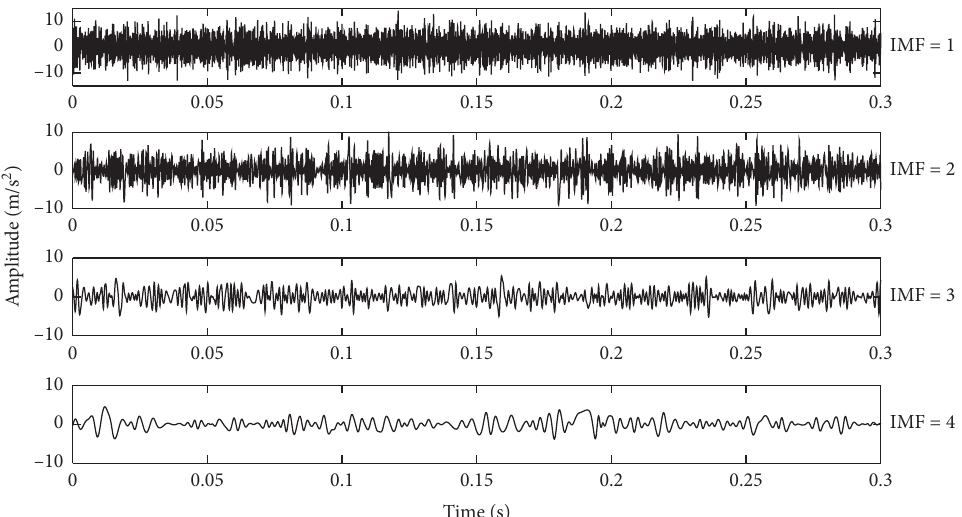
Figure 11: The first four IMF components after EMD.